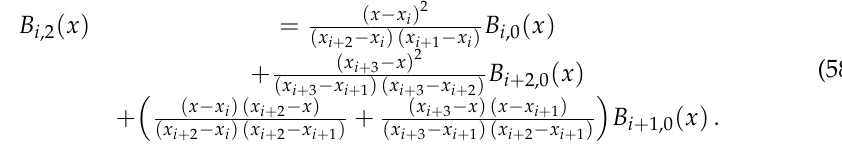
Figure 13. Quadratic B-Spline basis functions using the knots x k in two intervals k = 0 and k = 1, and the knot sequence [ 0,0, 0,1,3, 3,3 ] . The knots are marked with black triangles on the x -axis.